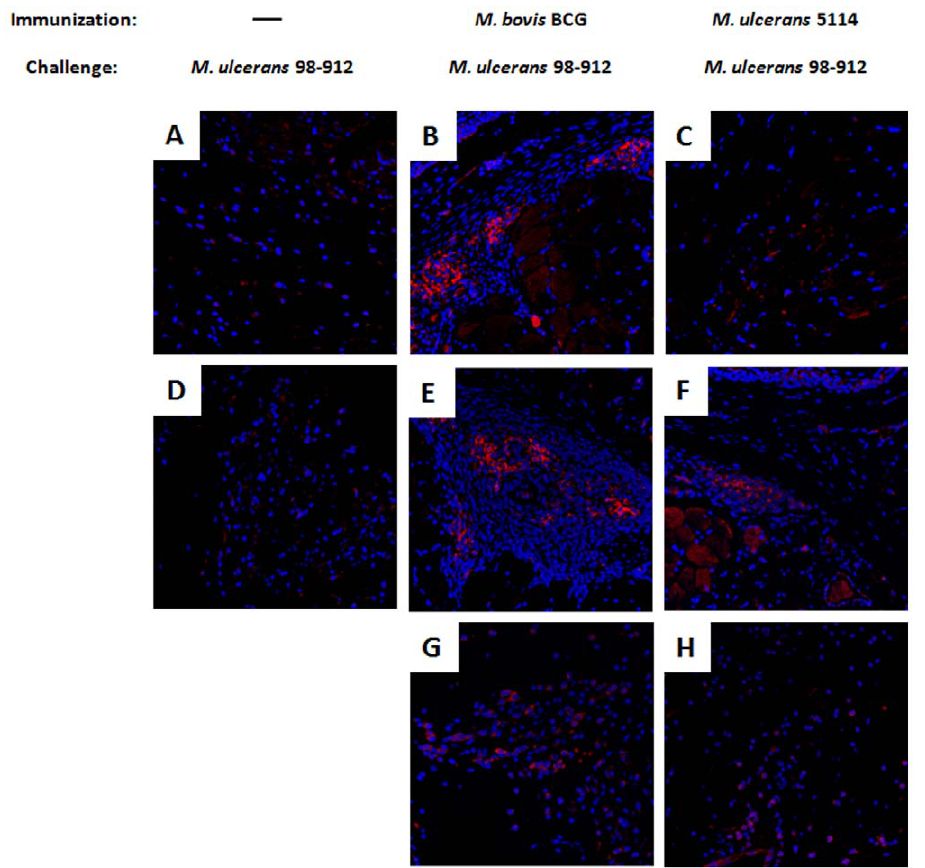
Figure 7. Immunization increases iNOS positivity in the footpad of M.ulcerans challenged mice. Mice were either non-immunized (A and D) or immunized with BCG (B, E, and G) or with mycolactone-negative M. ulcerans 5114 (C, F, and H) two months before challenge. All mice were infected in the footpad with 2 log 10 CFU of M. ulcerans 98–912. The footpads were harvested at on day 60 (A–C), day 70 (D–F), or day 100–200 (G–H and J–K) and processed for histology. Cells were stained for the presence of iNOS (red) and nuclei were stained with DAPI (blue). In footpads of non- immunized mice, scarce or no iNOS positive cells were found in the tissue (A, D). The footpads of vaccinated mice presented foci of iNOS positive cells during the initial weeks of infection (B–C and E–F). With progression of infection, iNOS positivity became sparse. Images are representative of 4 footpads per group. Original magnification: 20 6 .